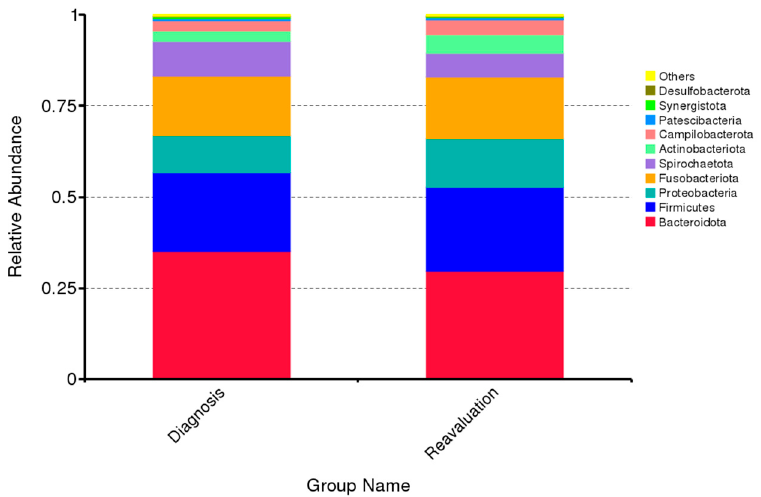
Figure 2. Mean levels of relative abundance of the 10 predominant phyla in subgingival samples at baseline and 6–8 weeks after treatment.